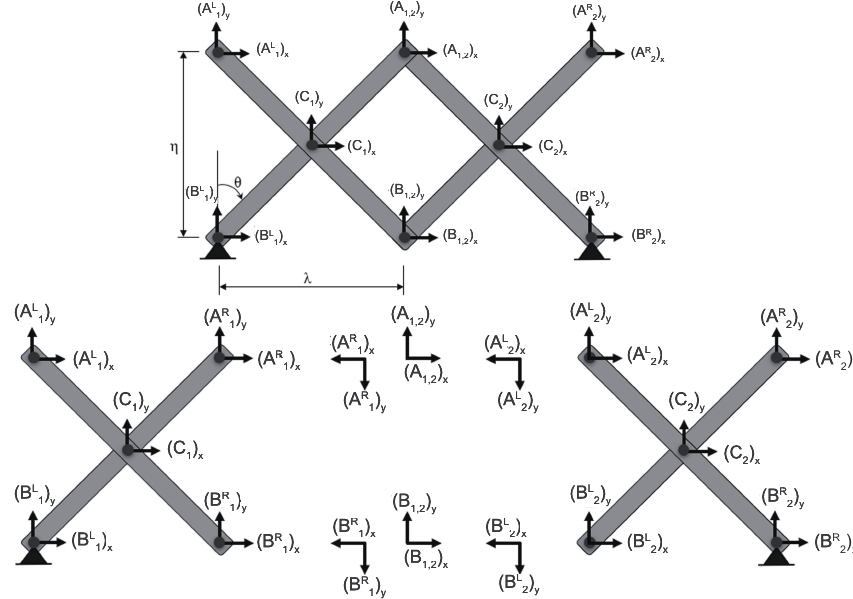
Figure 6. Two-units scissors structure by simple support